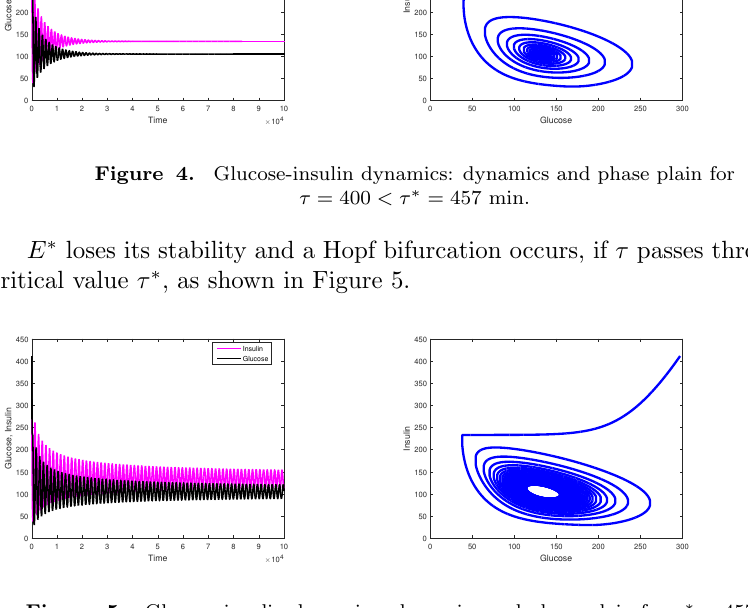
Figure 5. Glucose-insulin dynamics: dynamics and phase plain for τ ∗ = 457 min. Yet, it is unstable, and when it does, a Hopf bifurcation occurs if τ = 500 > τ ∗ , as shown in Figure 6.